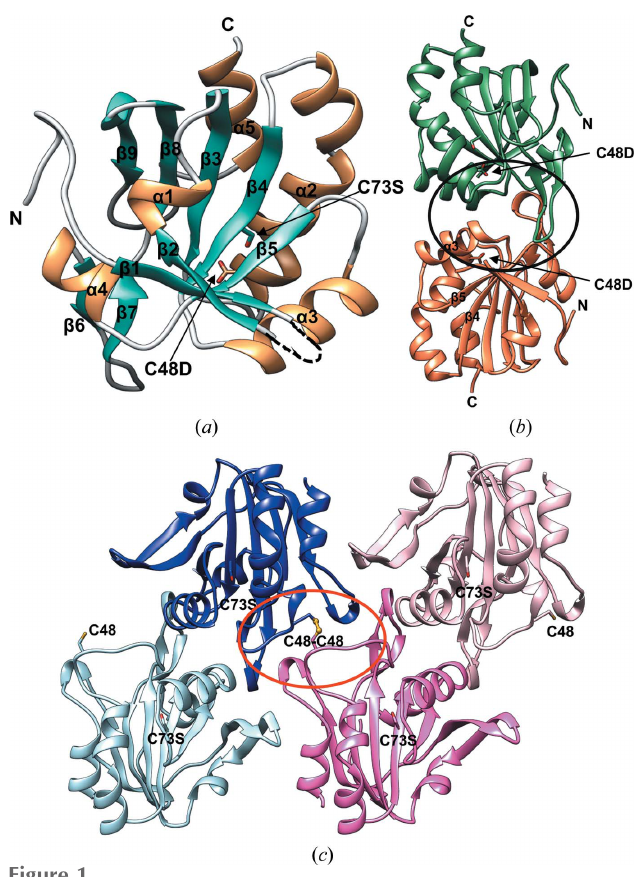
Figure 1 Overall structure and oligomeric interfaces of Vv Prx3. ( a ) Ribbon diagram of the reduced Prx3 (C48D/C73S) protomer; (cid:3) -helices, (cid:2) -strands and loops are represented in gold, green and grey, respectively. The black arrows indicate the side chains of the mutated residues Cys48 and Cys73. ( b ) Dimeric structure of reduced Prx3 (C48D/C73S) formed by an A-type interface (black circle). The two protomers are coloured differently (green and salmon). The side chains of Cys48 and Cys73 are shown in ball-and-stick representation. The black arrows indicate the side chains of the mutated residues (C48D). ( c ) The asymmetric unit of oxidized Prx3 (C73S) with intact Cys48. Two Cys48 residues from adjacent protomers form a disulfide bond. The crystals of oxidized Prx3 (C73S) were grown without reducing agent. Four protomers are drawn in different colours and the side chains of Cys48 and Ser73 are displayed as ball-and-stick models. The red circle represents the C-type